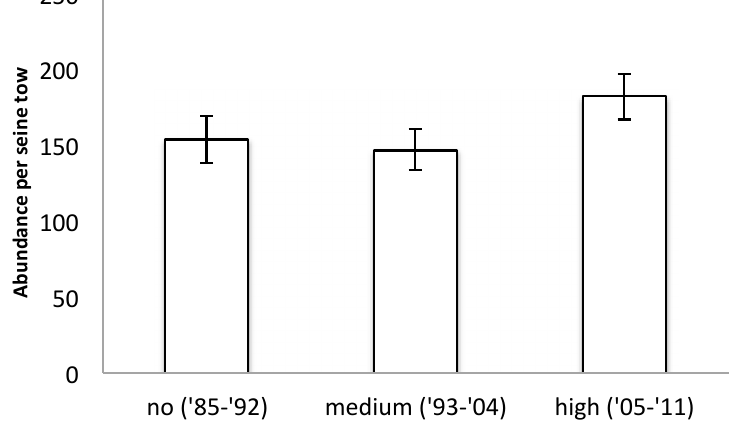
Figure 4. Total fish abundance per seine haul for the three time periods of 1985–1992, 1993–2004, and 2005–2011. Error bars indicate standard error. The labels ‘no’, ‘medium’, and ‘high’ refer to the SAV cover.